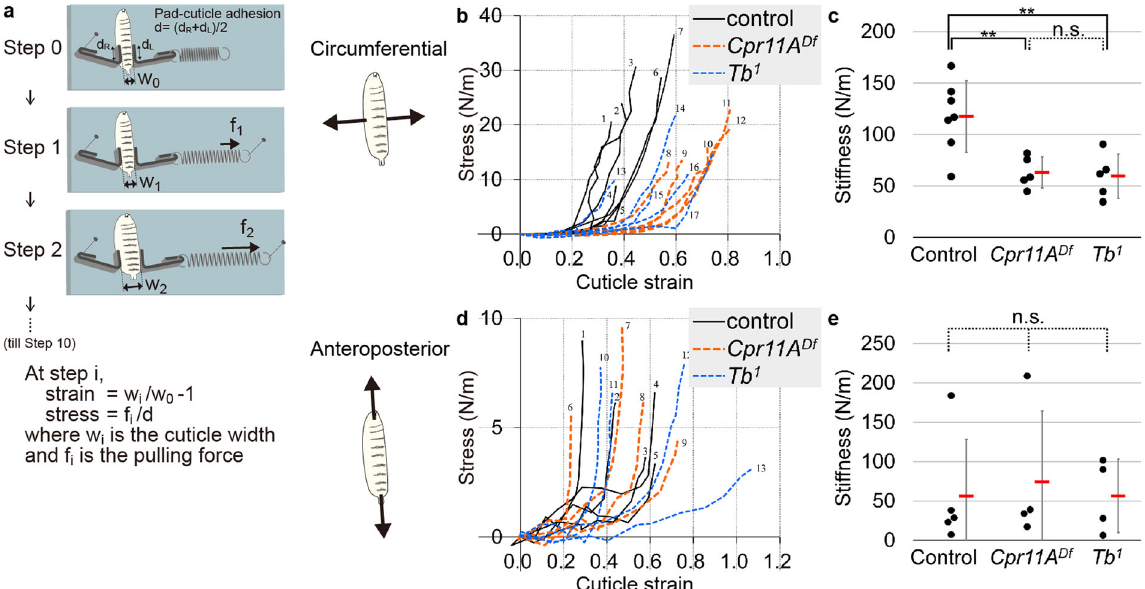
Fig. 3 Direct measurement of cuticle stiffness. a – c Measurement of cuticle stiffness along the body width (circumference). Numbers of individual larvae used for the measurement are 7 (control), 5 ( Cpr11A Df ) and 5 ( Tb 1 ). Signi fi cance was assessed using one-way ANOVA ( p = 0.0029) and Tukey ’ s multiple comparisons test. ** p < 0.01; n.s., not signi fi cant. d , e Measurement of cuticle stiffness along the body anteroposterior axis. Numbers of individual larvae used for the measurement are 5 (control), 4 ( Cpr11A Df ) and 4 ( Tb 1 ). No signi fi cant difference in cuticle anteroposterior stiffness was found, as assessed by one-way ANOVA ( p = 0.914). The larval identi fi ers in b and d (1, 2, … ) correspond to the data in Supplementary